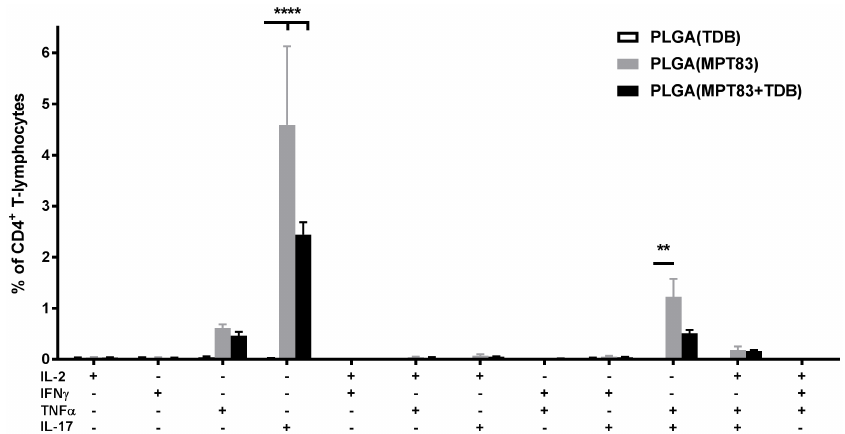
Fig 2. Mucosal delivery of PLGA vaccines with TDB induces antigen-specific cytokine responses locally in the lungs. Frequency of cytokine-producing CD4 + T-lymphocytes were assessed at four weeks following final i.n immunisation. Antigen-specific cells were detected by intra-cellular immunostaining and flow cytometry after recall with MPT83 (10 μ g/ml) for 12 hr followed by addition of Brefeldin A and further incubation for 4 hr. Data are the means ± SEM (n = 3) and are representative of two independent experiments. Statistically significant differences were determined by ANOVA with post-hoc Bonferroni comparison to adjuvant only control ( (cid:3)(cid:3) p < 0.01, (cid:3)(cid:3)(cid:3)(cid:3) p < 0.0001).